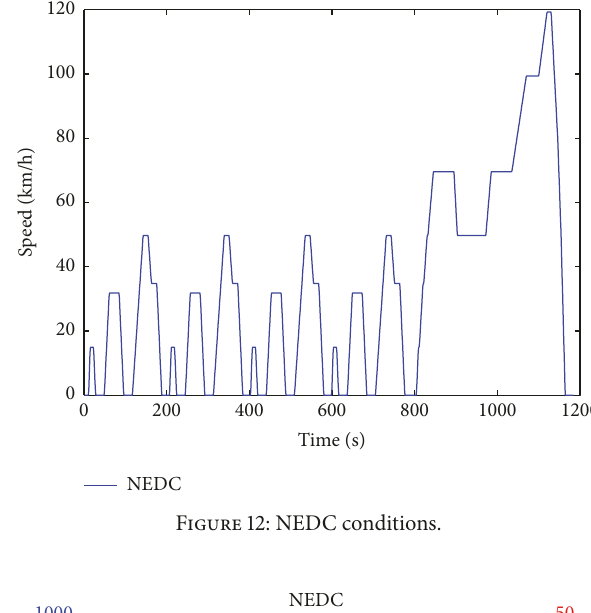
Figure 12: NEDC conditions.